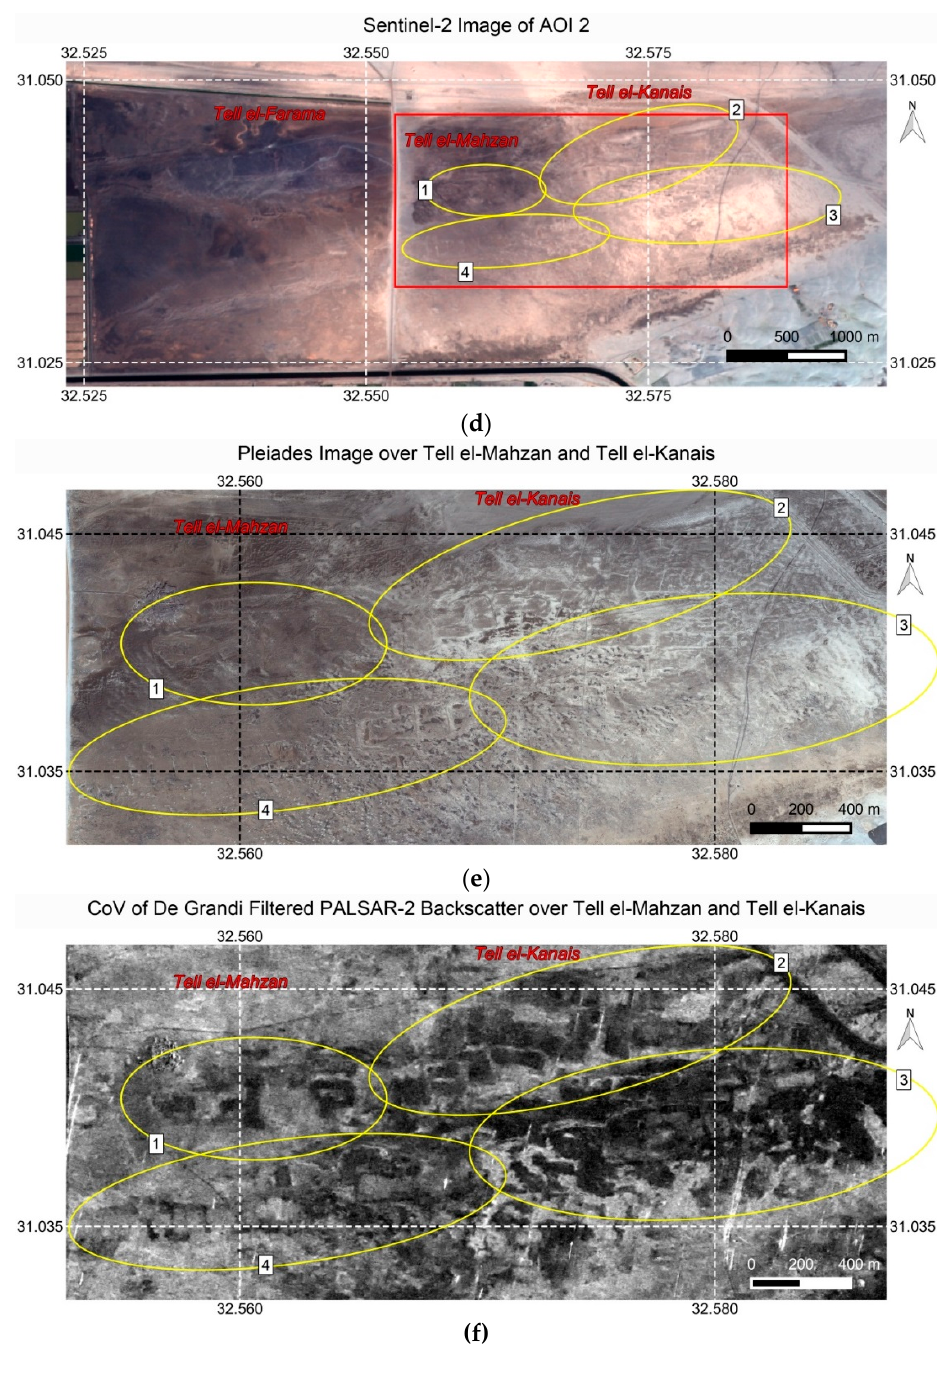
Figure 8. Cont. Figure 8.